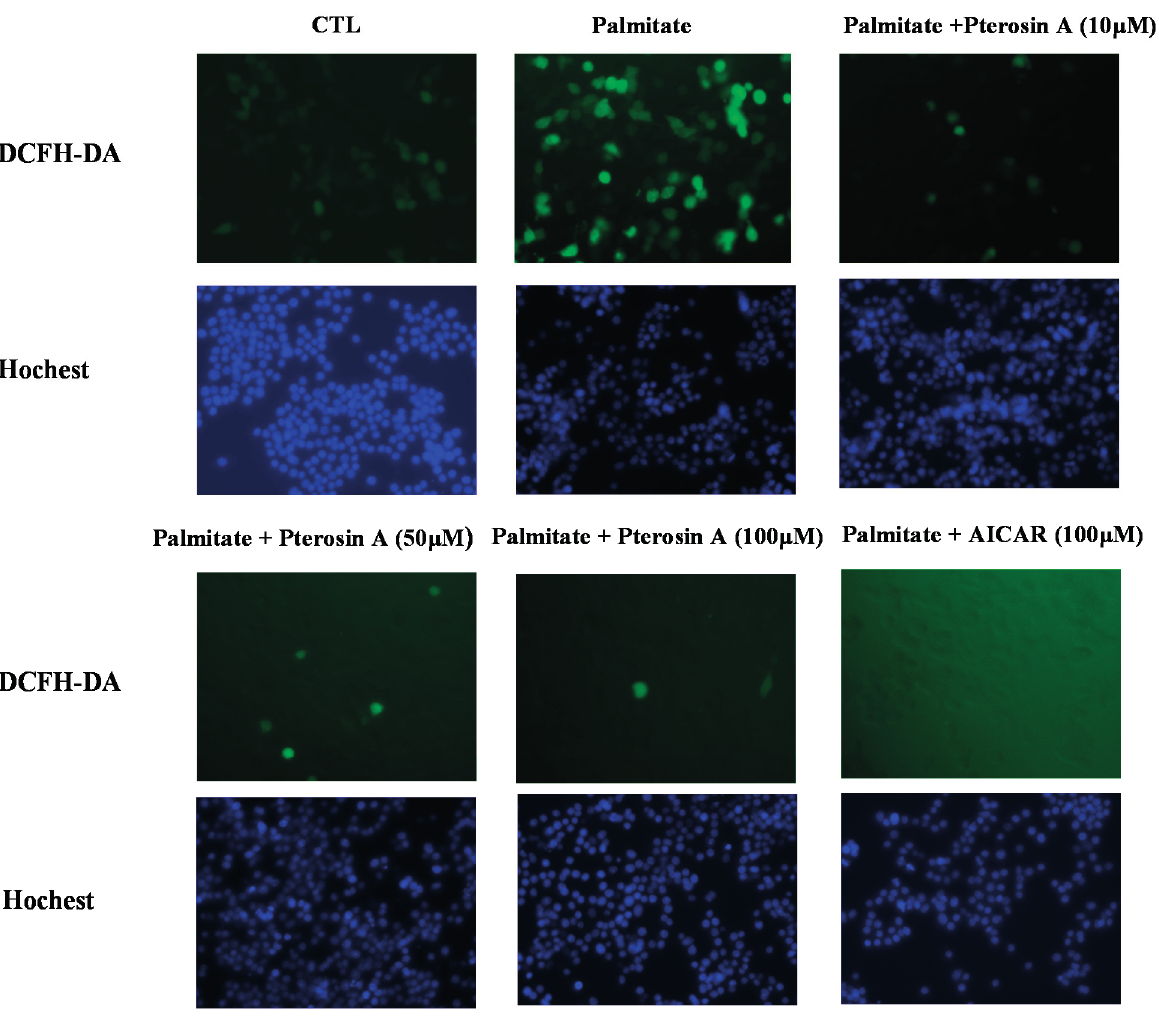
Figure 8. Effects of pterosin A on palmitate-induced ROS in RINm5F cells. The cells were exposed to various doses of pterosin A with palmitate (250 μ M) (A: AICAR was used as a positive control). Fluorescent microscopy to determine the ROS levels by 2',7'-dichlorofluorescein diacetate (DCFH-DA) staining (original magnification